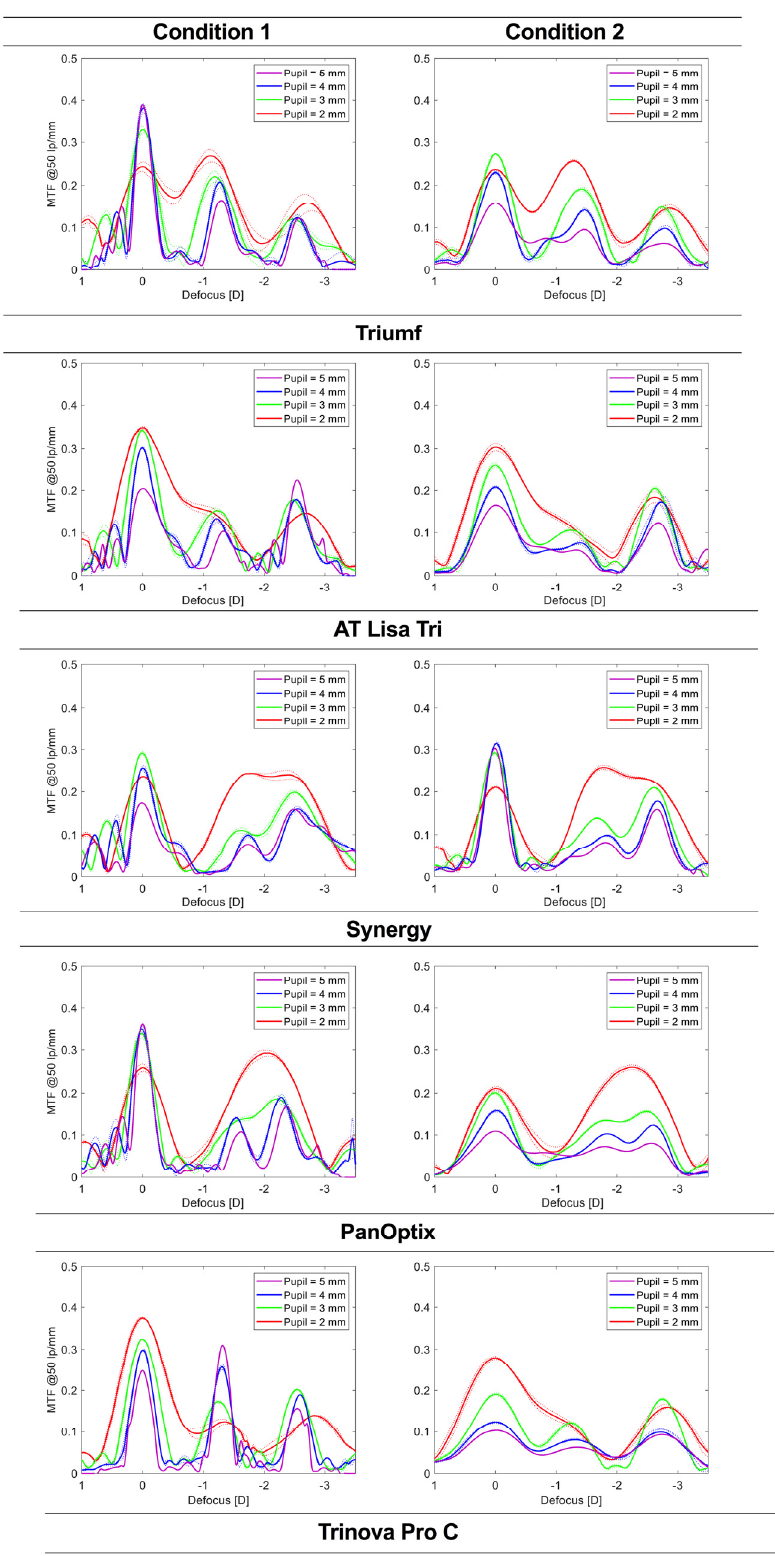
Figure 4. The through-focus modulation transfer function (MTF) curves at 50 lp/mm (equivalent to 15 cyc/dec) and at various pupil sizes. Monochromatic light with an aberration-neutral corneal model was applied in Condition 1, and polychromatic light with a population level of corneal spherical aberration in Condition 2. The dotted lines show the values of each lens separately; the solid lines refer to the average of two samples.